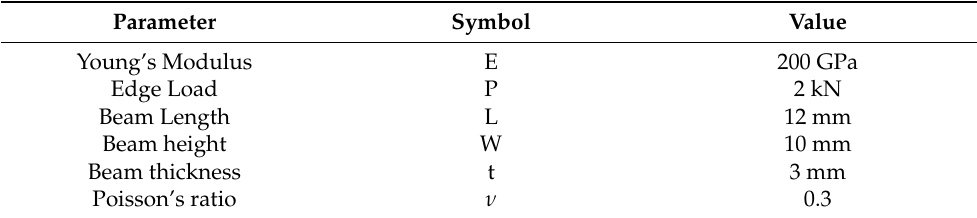
Table A2. Beam Problem